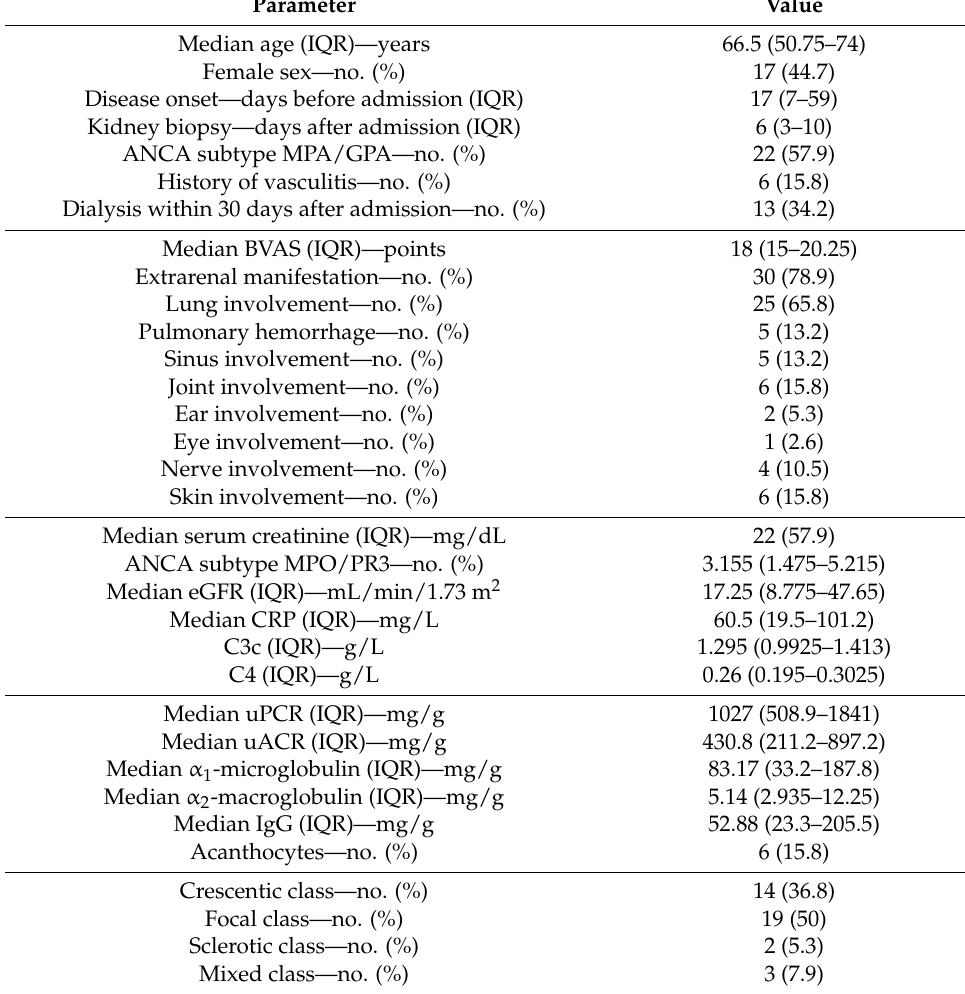
Table 1. Clinical and laboratory parameters of the total ANCA GN